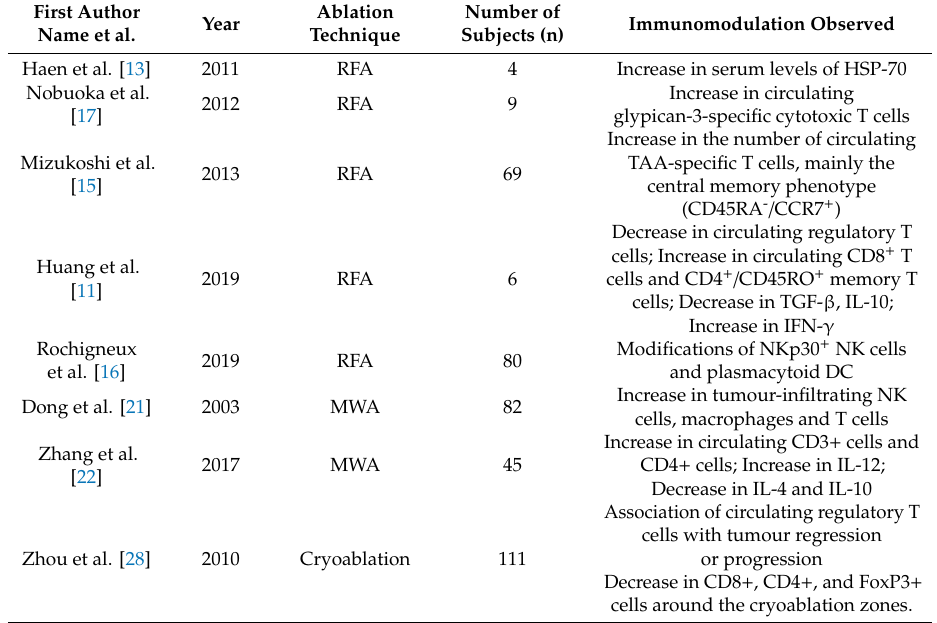
Table 1. Summary of principal human studies focused on RFA-, MWA- or cryoablation-induced immunomodulation in hepatocellular